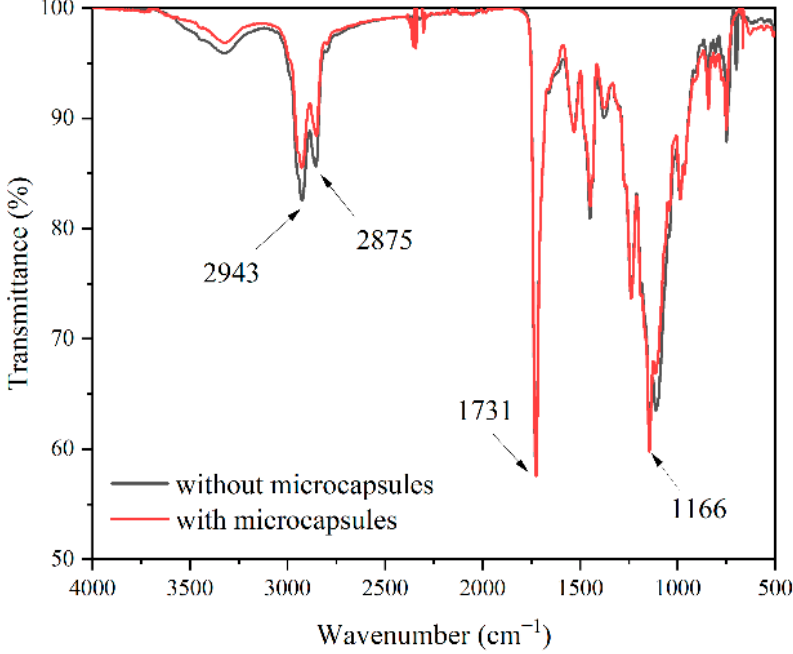
Figure 5. Infrared spectrum of paint film on three times of primer and two times of finish.